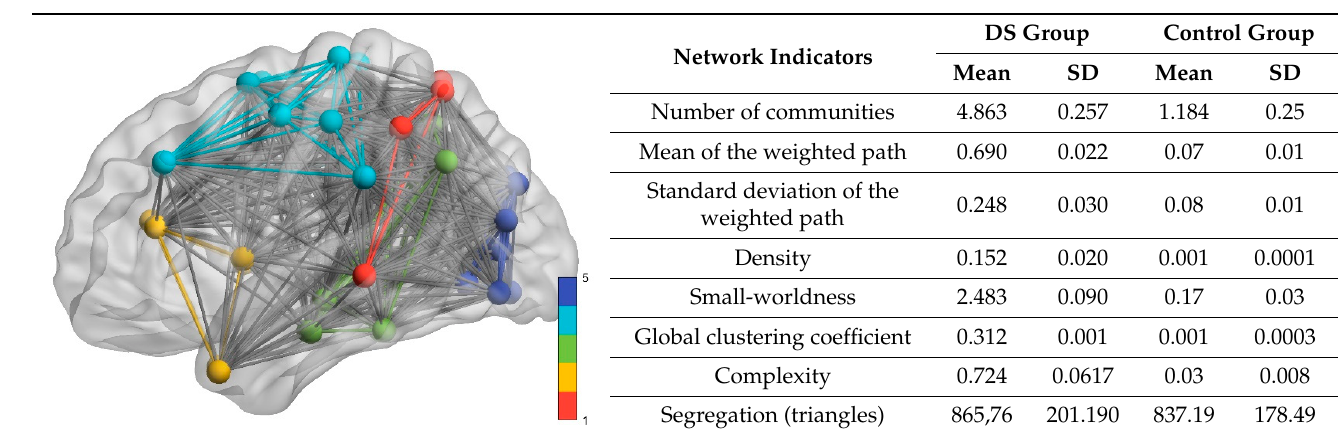
Table 5. Pearson correlations between